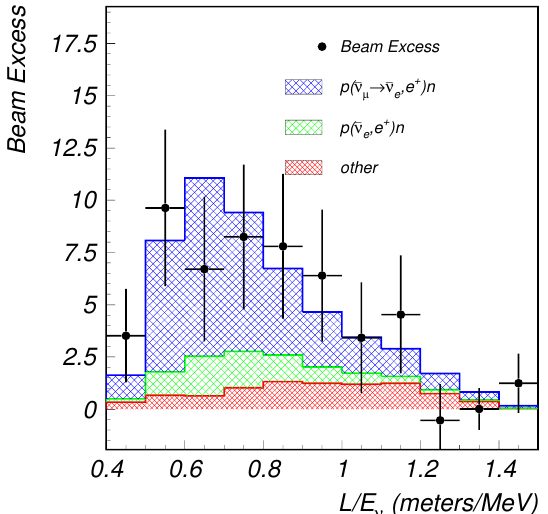
Figure 1: ¯ ν excess over background (green) observed by the LSND experiment. The e blue line corresponds to the prediction if the excess is due to neutrino masses with ∆ m 2 ∼ eV